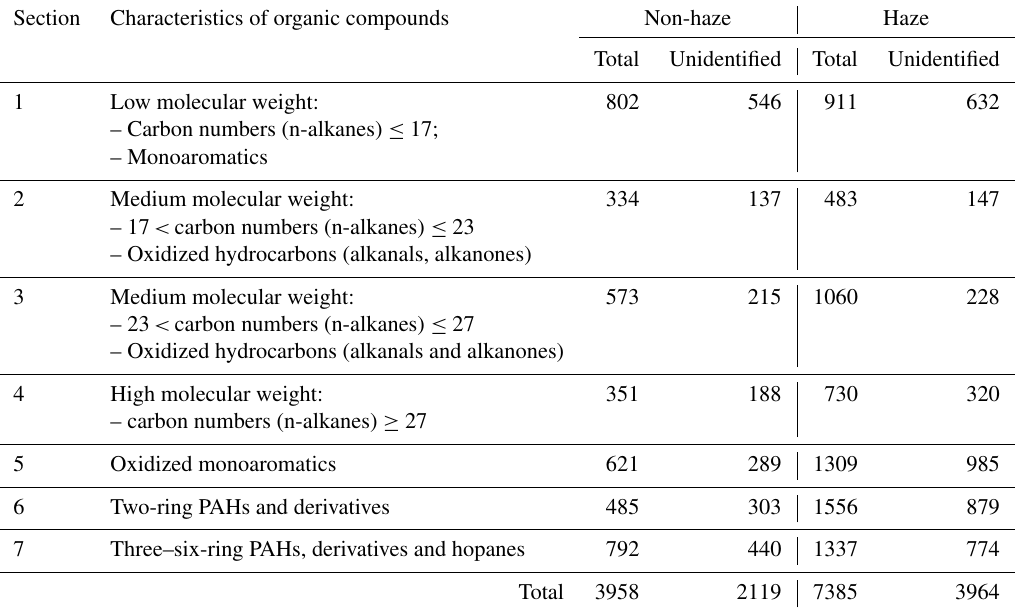
Table 3. Estimated average concentrations of unknown compounds (ngm − 3 ) in each section of the chromatogram for haze and non-haze